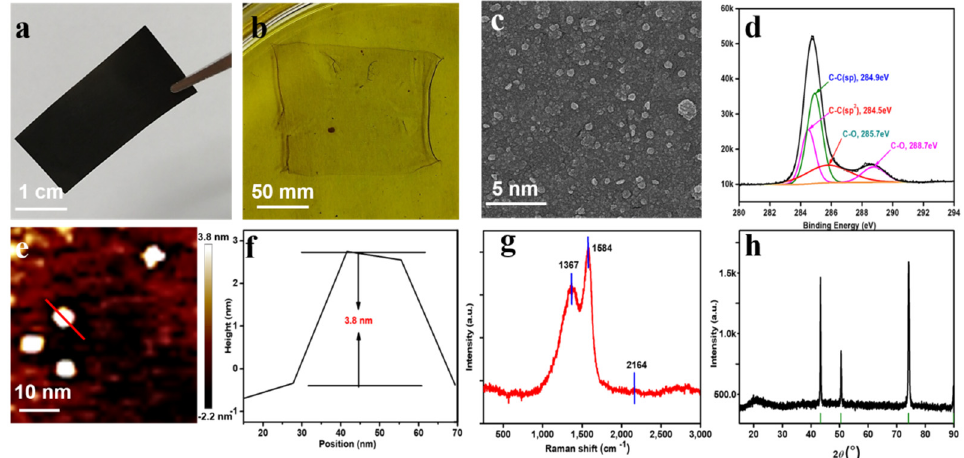
Figure 1. Morphology characterizations of graphdiyne. ( a ) Photograph of the prepared large size GDY on copper foil; ( b ) Photograph of the prepared large size GDY membrane via wet stripping; ( c ) HR-TEM image of graphdiyne, scale bar: 5 nm; ( d ) XPS spectra of graphdiyne film, narrow scan for element C. ( e ) AFM image of the GDY QDs showing the particle thickness. Scale bar: 10 nm. ( f ) The particle size distribution in ( e ), and the average particle size is 3.8 nm. ( g ) Raman spectra of the as-prepared GDY film. ( h ) XRD pattern of graphdiyne QDs.